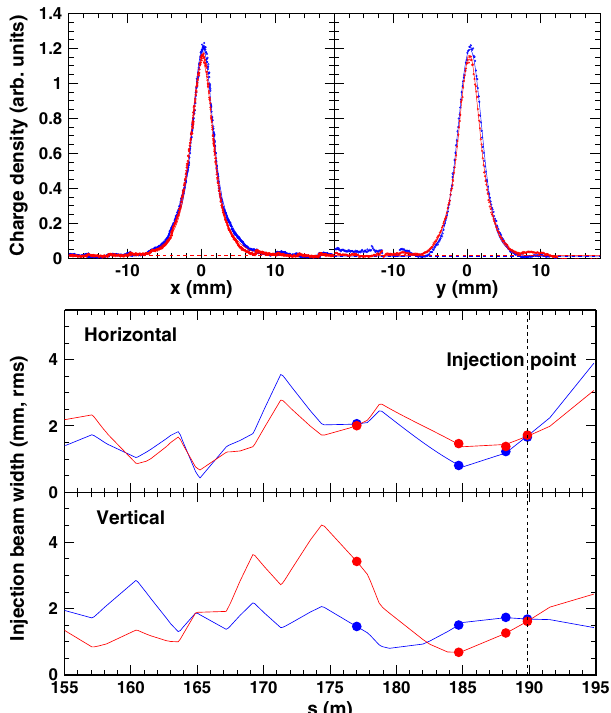
FIG. 24. (Upper) Transverse injection beam profiles measured at the RCS injection point. (Lower) Injection beam envelopes along the injection beam transport line reconstructed by model fitting to measured injection beam widths (circles). In these plots, the blue ones are those before the correction of the injection beam Twiss parameter, while the red ones are those after the